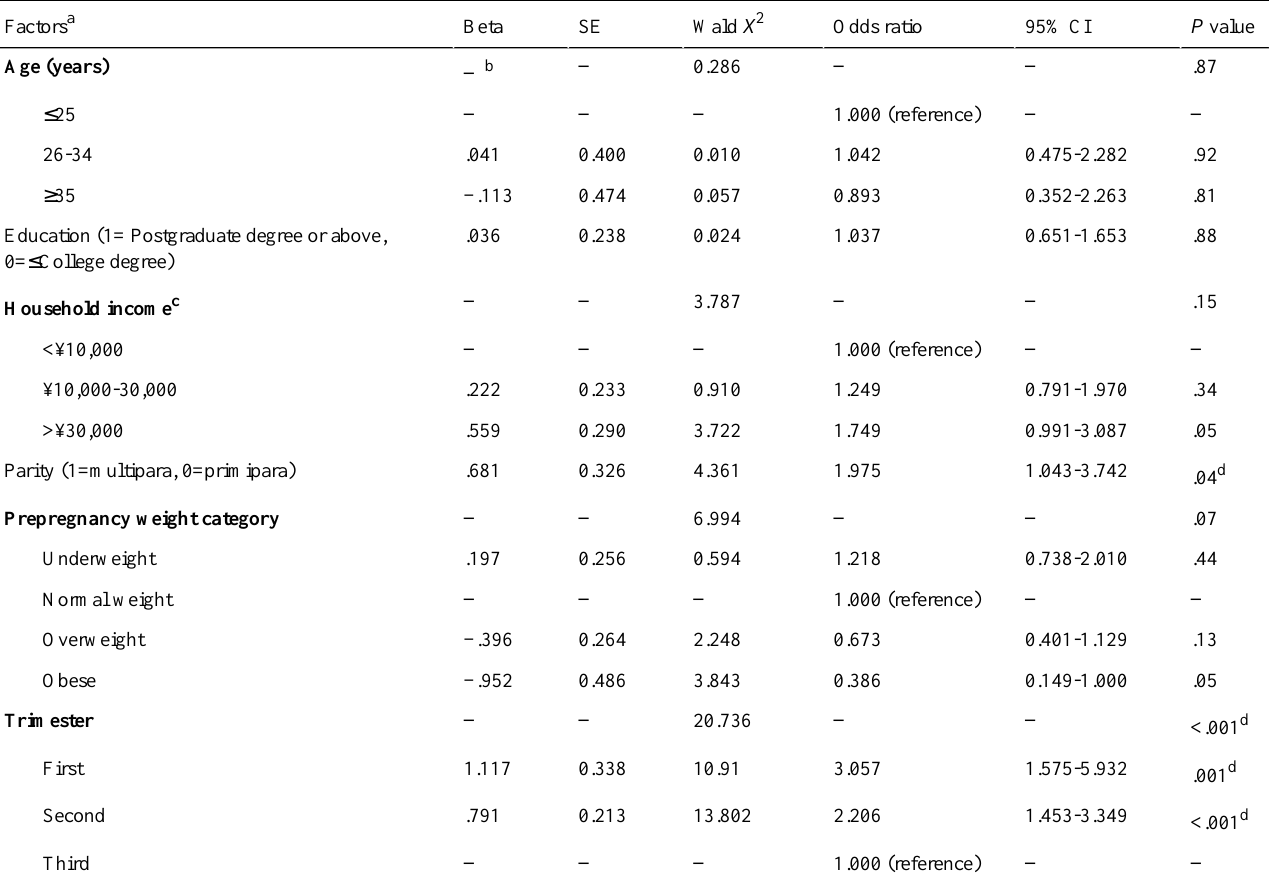
Table 3. Results of a multivariable logistic regression analysis of factors associated with app usage of pregnant women in Shanghai, China (N=528; after exclusion of 7 cases for missing data on household